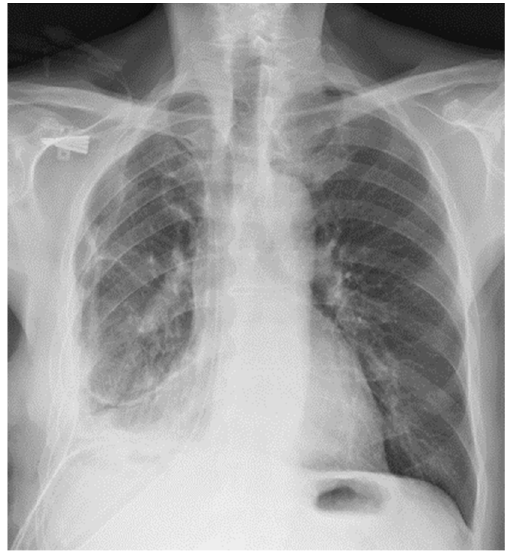
Figure 2. Postoperative X-ray.